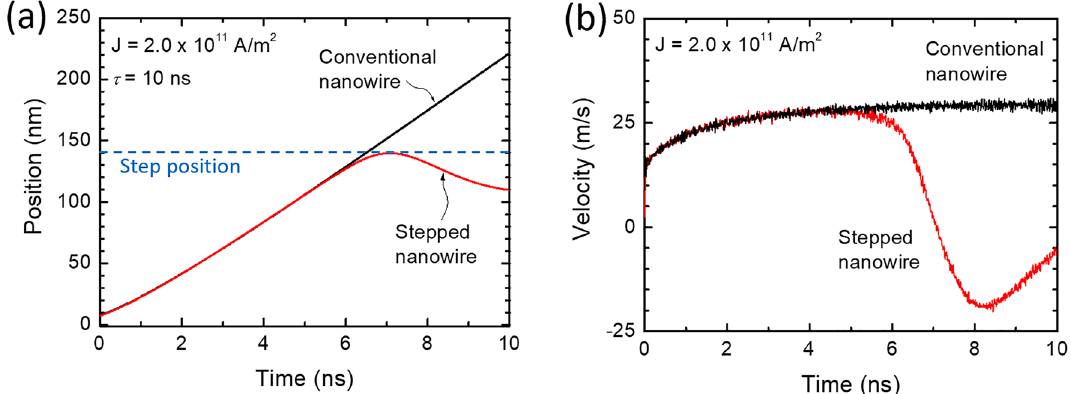
Figure 3. ( a ) The skyrmion position versus time when the current pulse of 2 × 10 11 A/m 2 is applied for 10 ns. ( b ) The velocity versus time for the both conventional and stepped